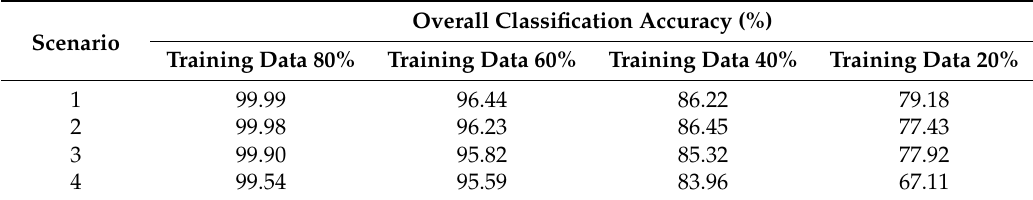
Table 4. Classification results for different sizes of training data.